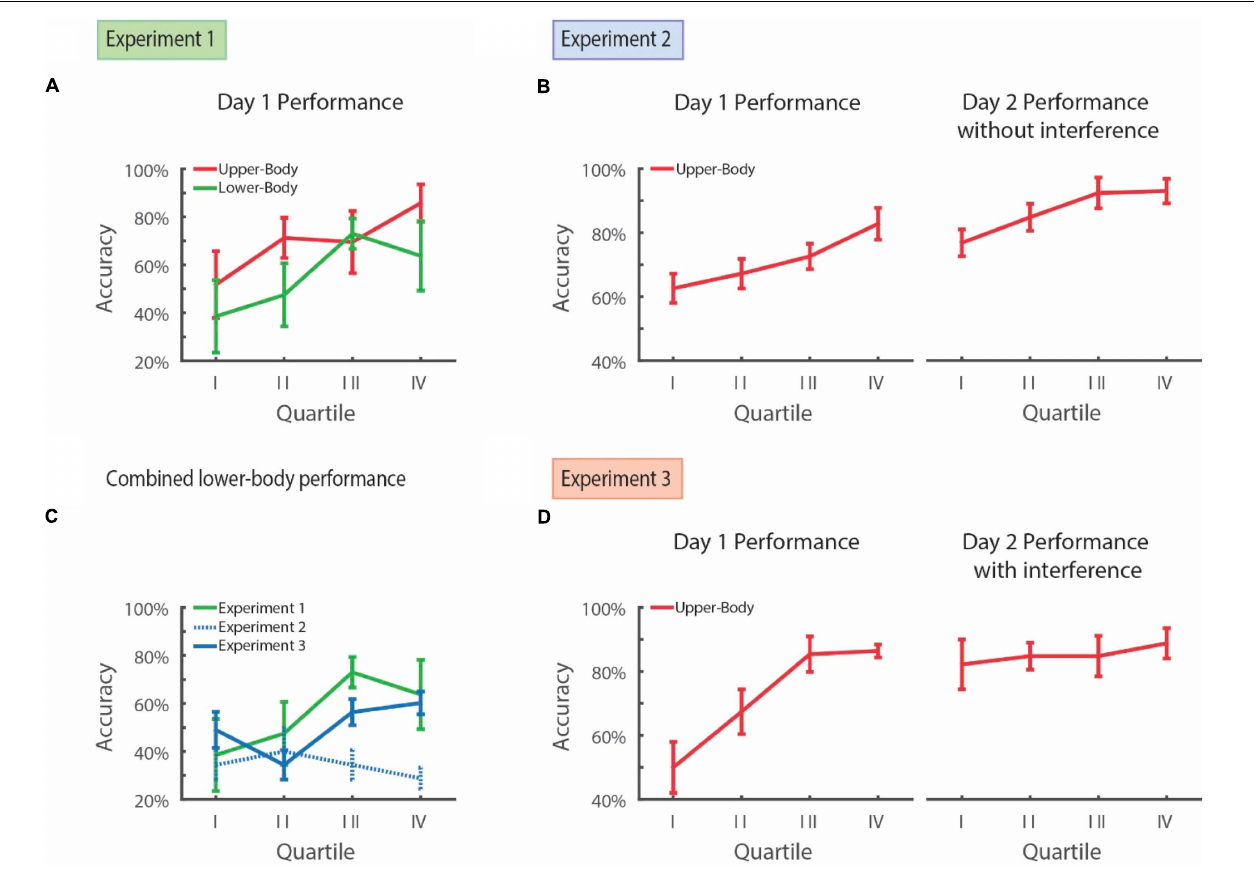
FIGURE 2 | Long-term improvement in visual search after training and learning suppression. (A) Subjects performing simultaenous visual search for both upper- and lower-body in Experiment 1 demonstrate improvement in both overall and subcategory learning over the course of a single day. (B) Participants in Experiment 2 show learning over the course of Day 1 on upper-body visual search and this level of accuracy is maintained the following day for the upper-body visual search subcategory. (C) Subjects in Experiment 3, who performed the interference task on the prior day, demonstrated accuracy on the novel lower-body search task similar to subjects who participated in this task on Day 1 of Experiment 1. In contrast, subjects in Experiment 2, who did not perform the interference task on the prior day, showed significantly lower accuracy on the novel lower-body search task. (D) Subjects in Experiment 3 show improvement in upper-body learning during the course of Day 1 and, following an interference task on the 1st day, maintain this level of accuracy on the following day for the upper-body subcategory. Error bars represent ± 1 SEM